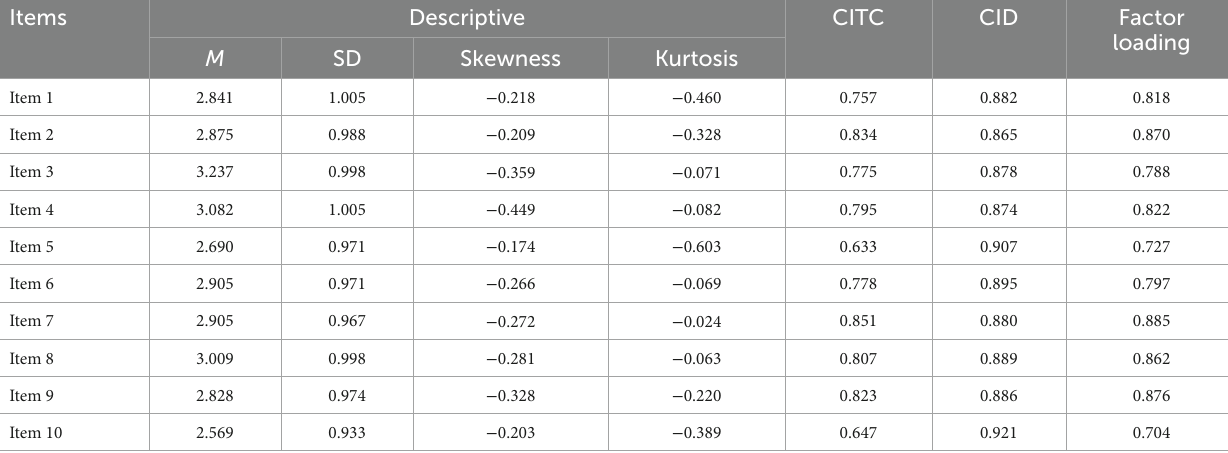
TABLE 2 Item properties of the 10-item Korean version of GSHCS.